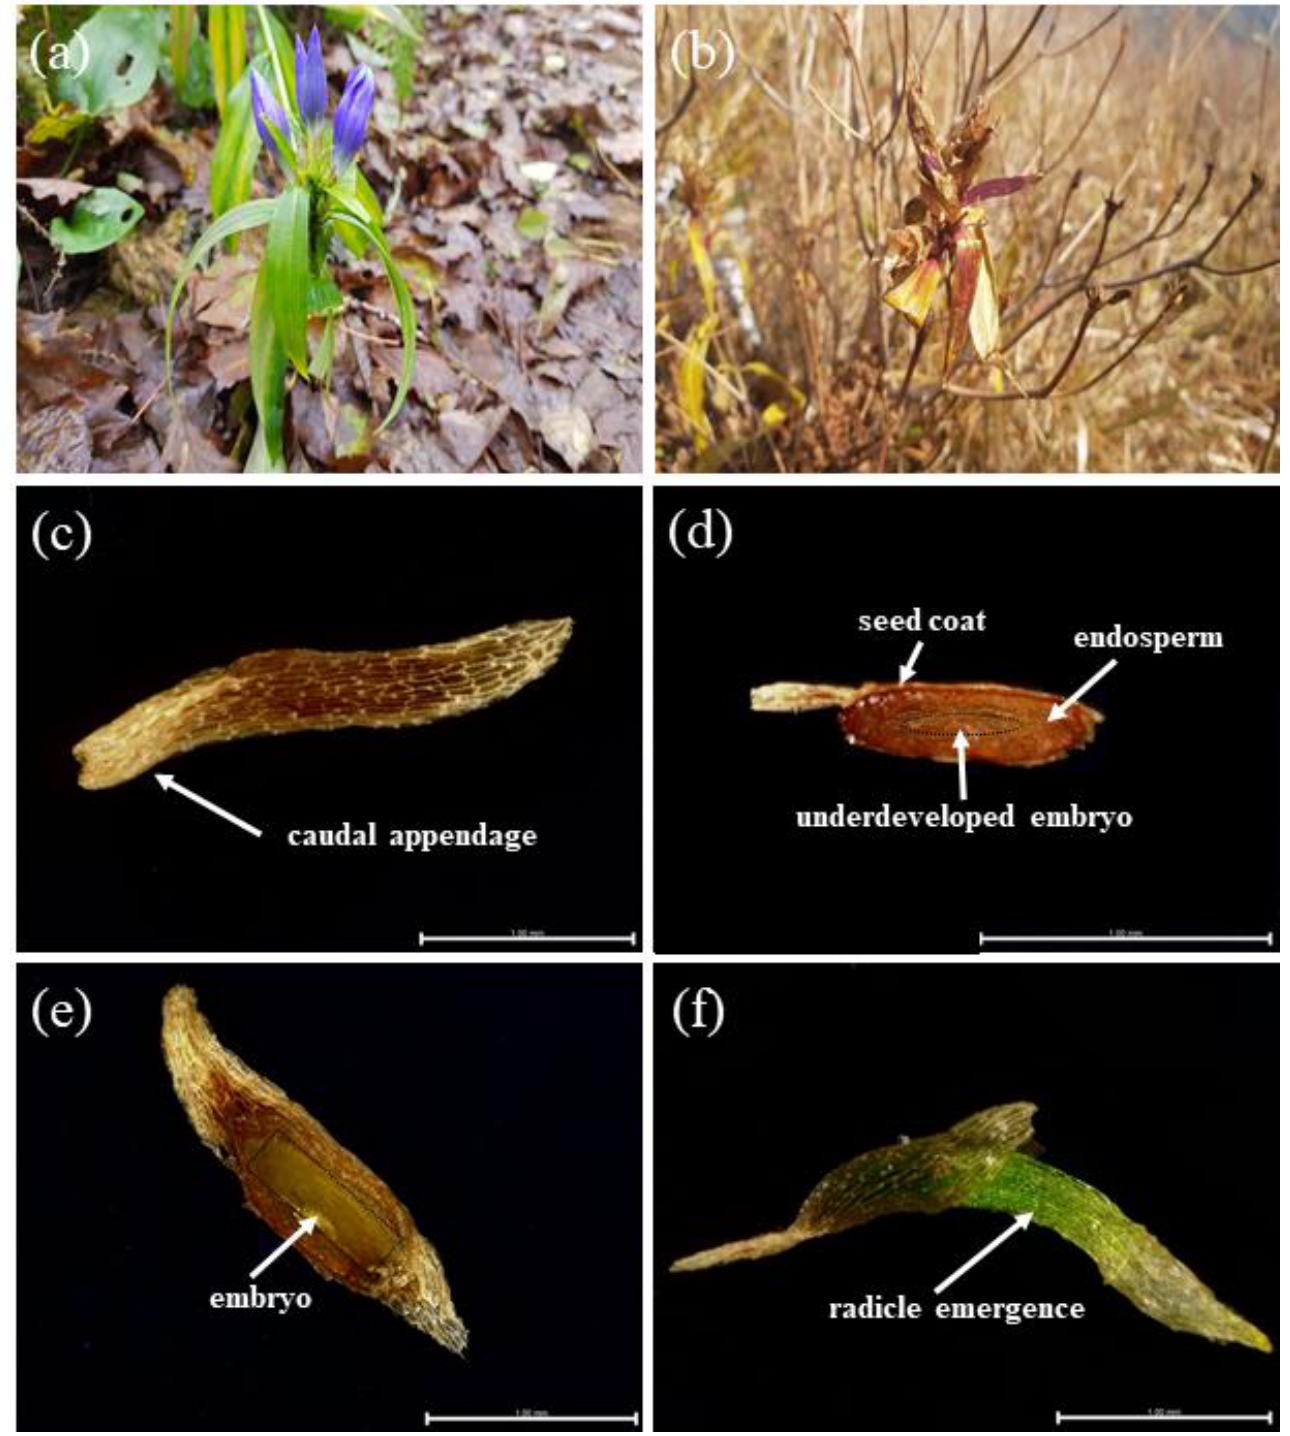
Figure 2. Flowers ( a ), capsules ( b ), seed ( c ), underdeveloped embryo at dispersal ( d ), fully developed embryo just before germination ( e ), and radicle emergence ( f ) of Gentiana triflora var. japonica (Kusn.) H. Hara (scale bar = 1 mm).